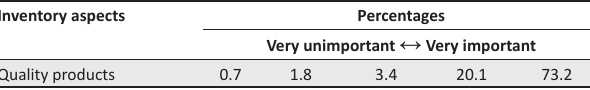
TABLE 6: Respondents’ importance rating of providing quality products to customers. Inventory